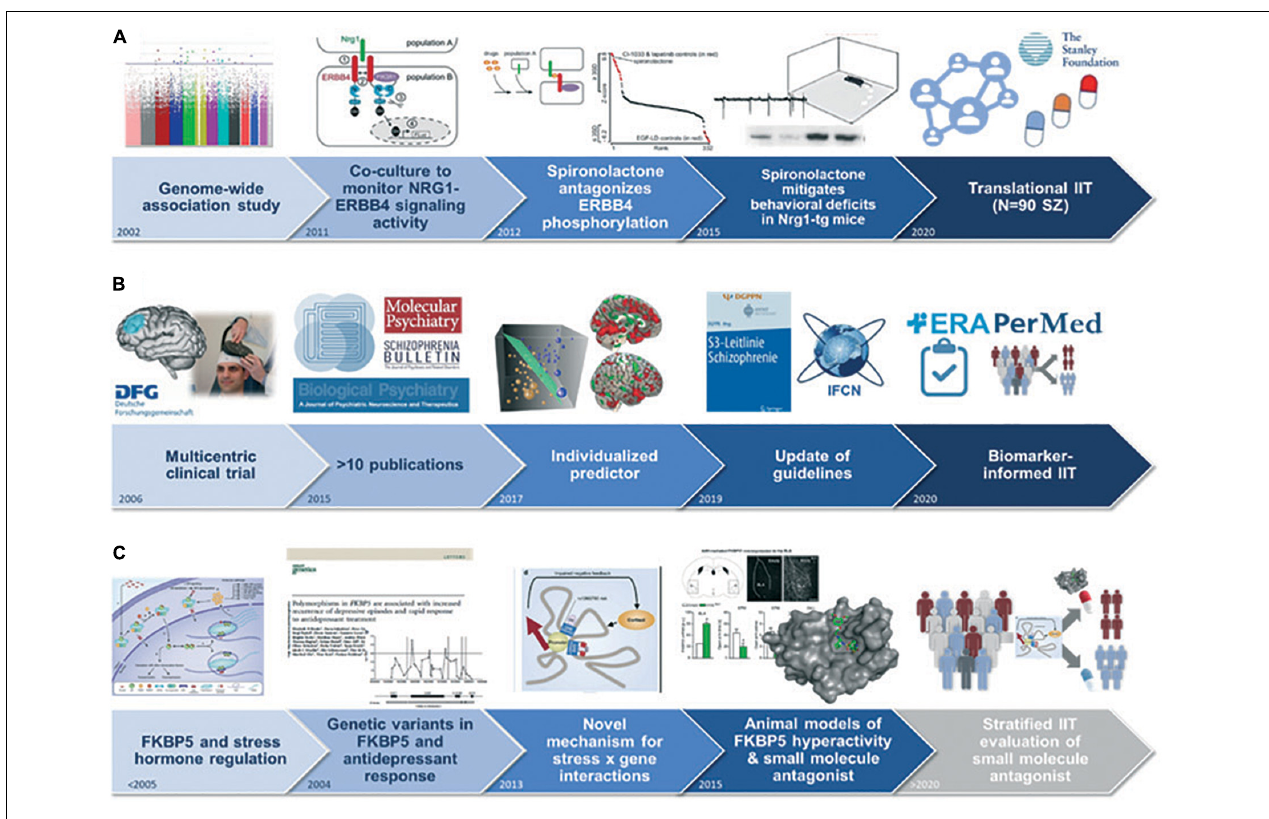
FIGURE 4 | Use cases exemplifying the potential of biomarkers and risk prediction models for clinical translation: (A) Development and clinical evaluation of spironolactone as treatment for cognitive deficits in patients with schizophrenia (42). (B) Development and validation of an individualized structural magnetic resonance imaging-based rTMS response predictor for the targeted treatment of negative symptoms in schizophrenia (43). (C) Identification of a molecular mechanism of difficult-to-treat depression leading to the development of a small-molecule antagonist of FKBP5-induced disinhibition in rodents, with planned clinical translation (44, 45). IIT, investigator-initiated